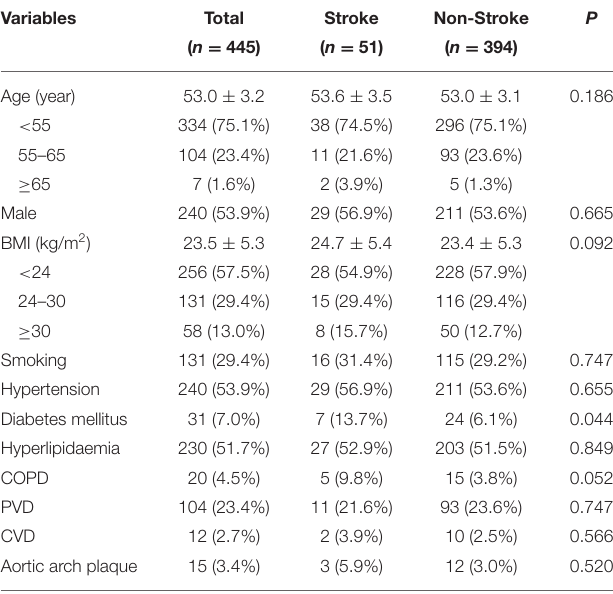
TABLE 1 | Demographic characteristics and preoperative data of